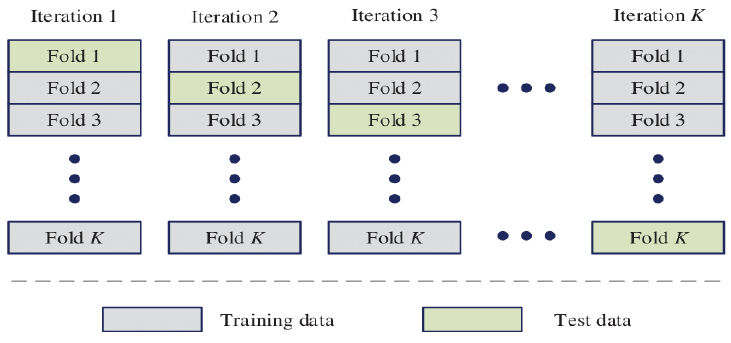
Figure 4. Block diagram of K-fold cross-validation.